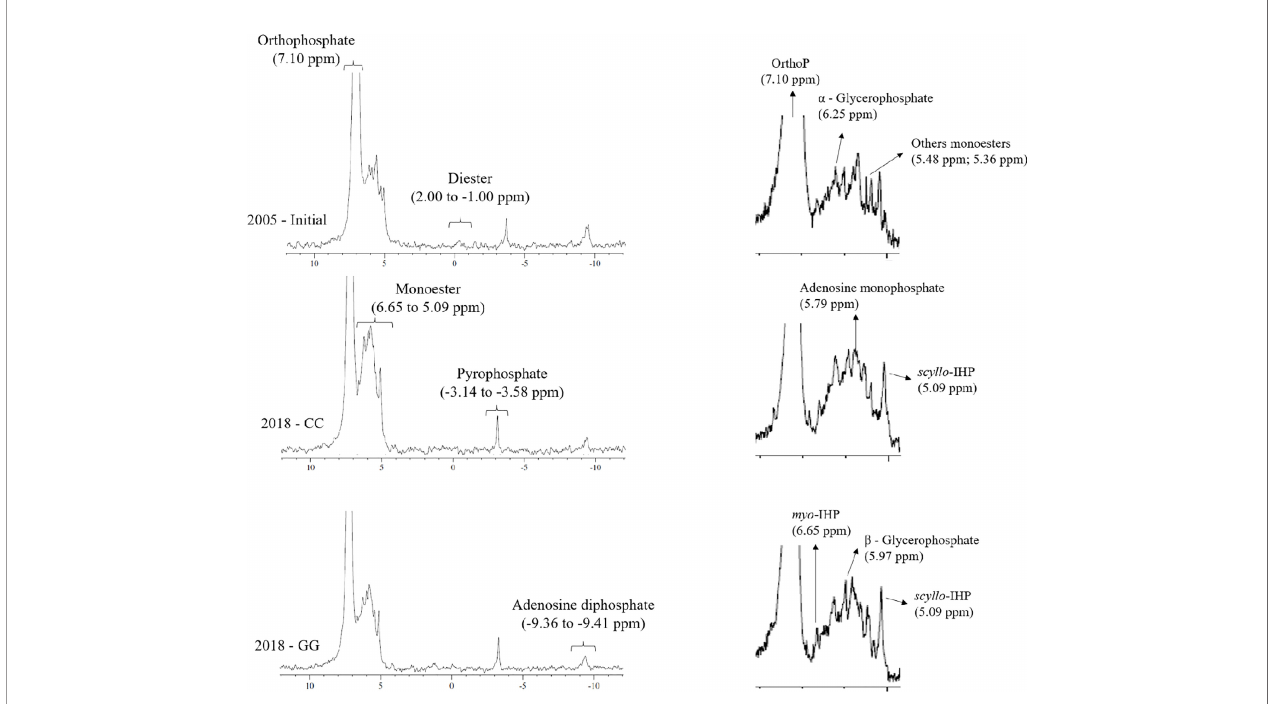
FIGURE 8 | 31P-NMR spectrum of a representative composite of soil samples at the beginning (2005) and after 13 years of CC and GG soil management practices. CC-permanent cropland and GG-permanent